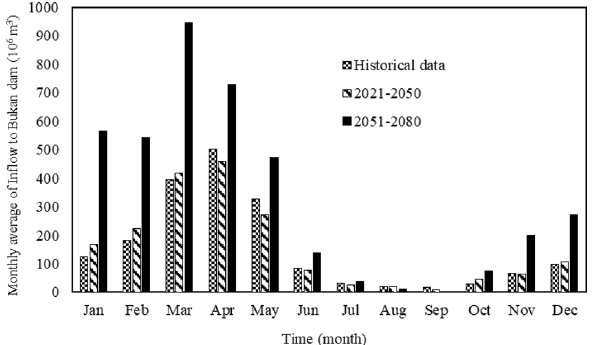
Figure 6. Simulated Bukan reservoir monthly inflows in the historical period and the two future periods.